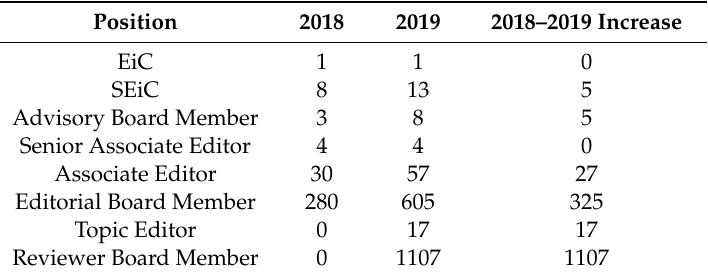
Table 3. The summary of team construction in the past two